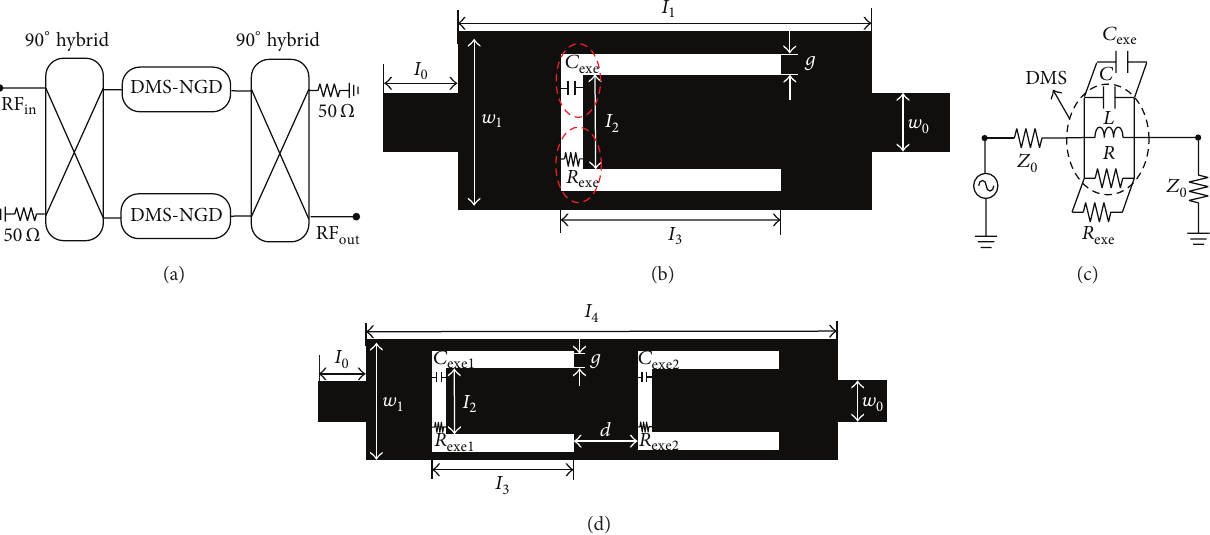
Figure 1: Proposed NGD networks: (a) configuration of balanced-type structure, (b) single-stage DMS-NGD network, (c) equivalent circuit of a single-stage DMS-NGD network, and (d) cascaded two-stage network.